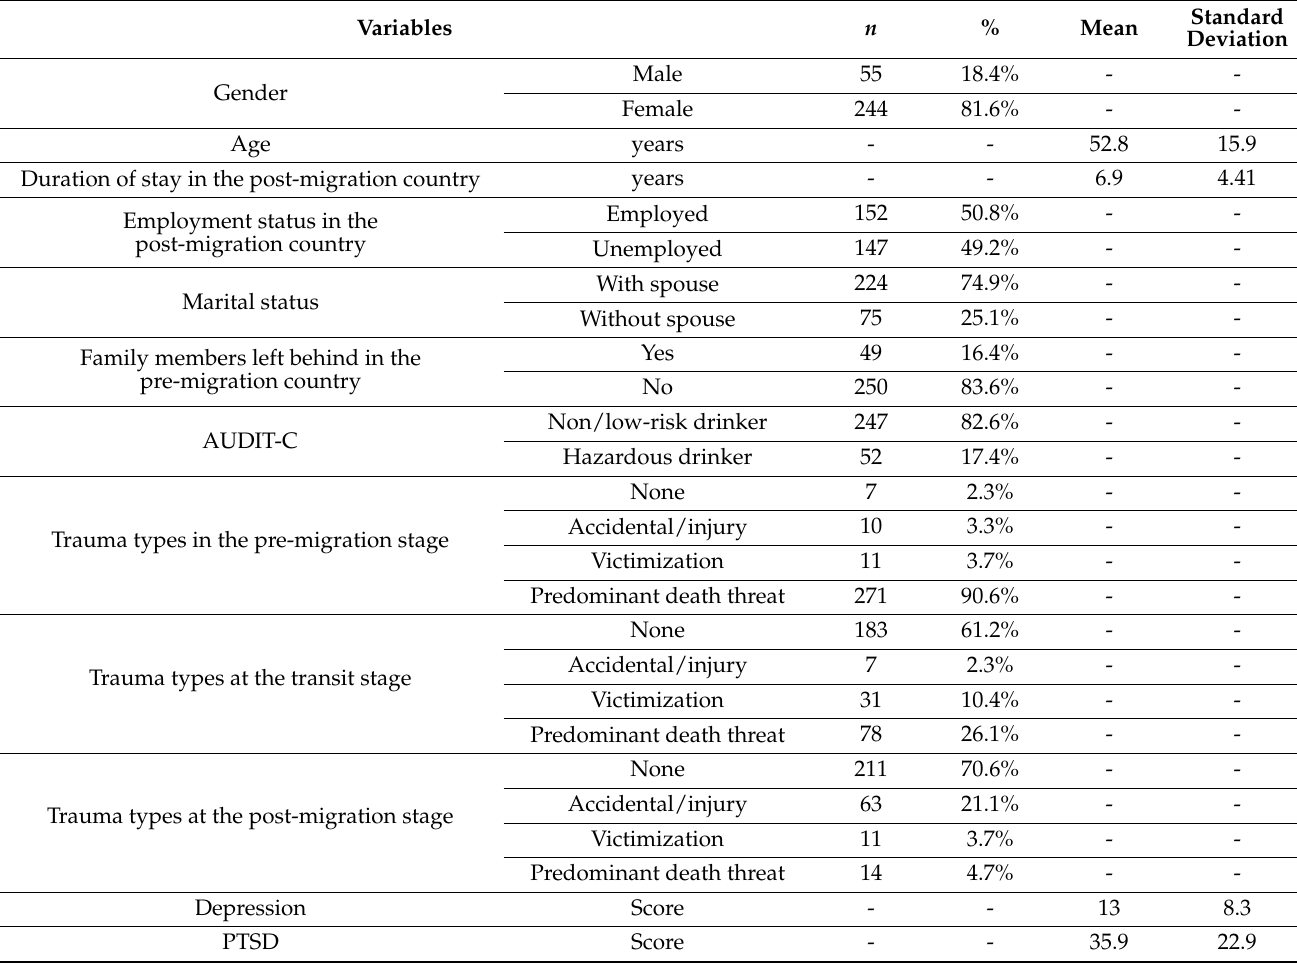
Table 1. Sample characteristics ( n =